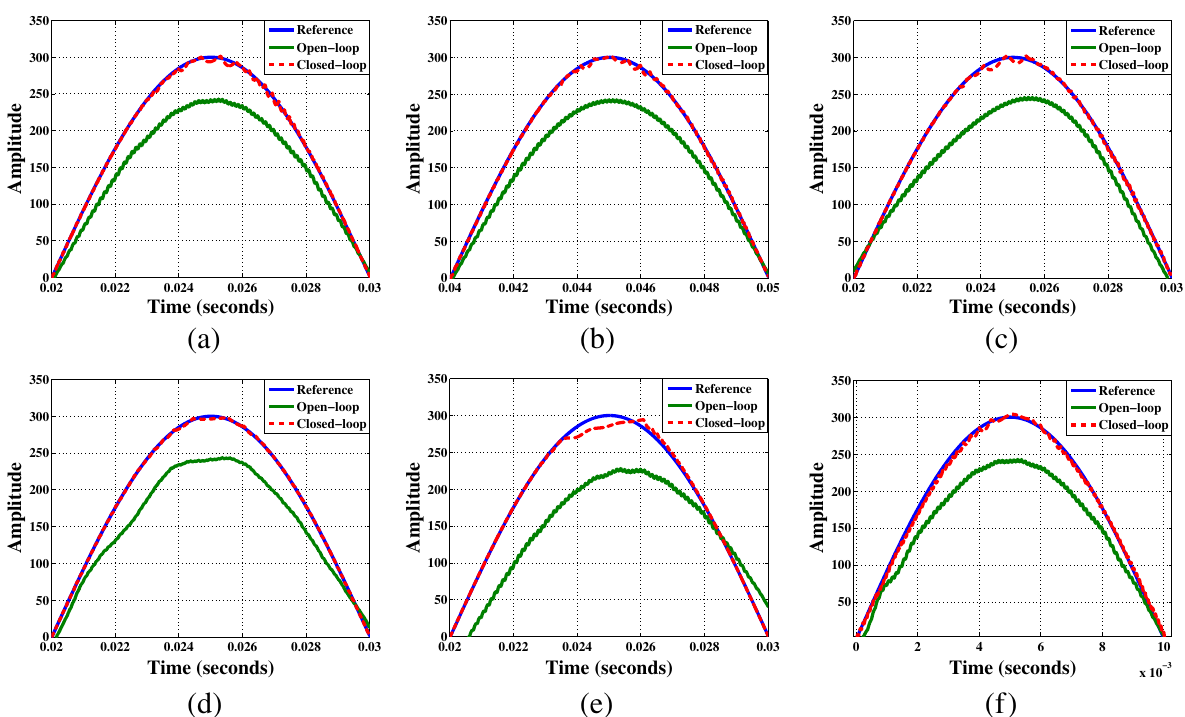
Fig. 18 Grid Voltage Tracking Using Model Predictive Controller for ( a ) Consumer Load, ( b ) Dynamic Load, ( c ) Harmonics Load, ( d ) Unknown Load, ( e ) Asynchronous Machine Load, ( f ) Non-linear Load. The Blue (-) and Green (-) Solid Line Represents the Reference and Open-Loop Voltage Respectively and Red (- -) Dashed Line Represents the Closed-Loop Grid